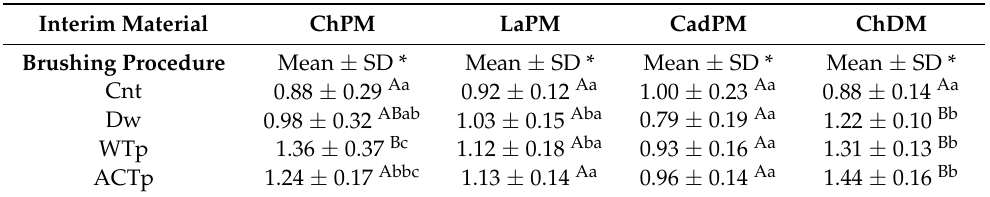
Table 4. Mean ∆ E 00 values and standard deviations (SD) of test groups with Tukey’s HSD multi- ple